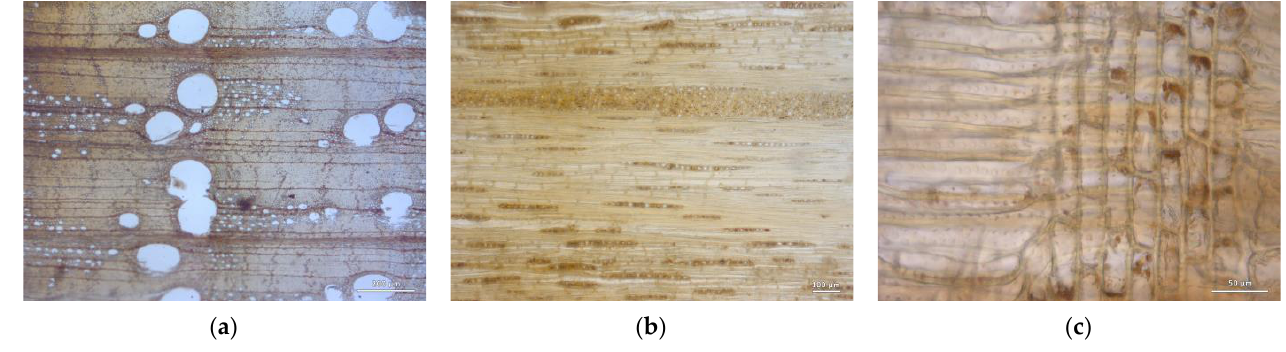
Figure 10. Characteristic sections identified as belonging to the Quercus genus: ( a ) Transversal section of sample PA2; ( b ) Longitudinal section of sample LE2; ( c ) Radial section of sample RI3.